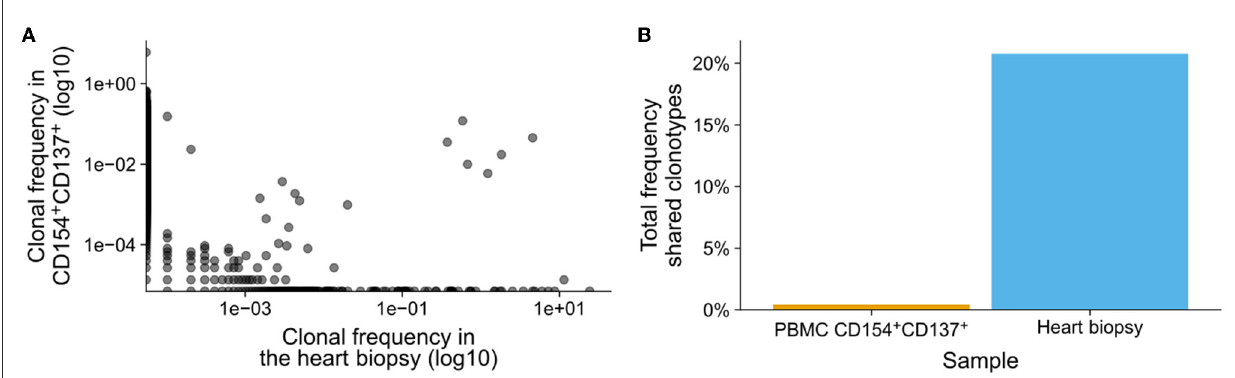
FIGURE2 SARS-CoV-2 specific T cells in heart biopsy. Peripheral blood T cells were stimulated with over lapping peptide pools from SARS-CoV-2S, M, and N proteins. Activated SARS-CoV-2-specific T cells were isolated by magnetic sorting and the T cell receptors (TCRs) were sequenced using mRNA. In parallel, TCRs from bulk mRNA from a heart biopsy were also sequenced. (A) Frequency of clonotypes identified in the heart biopsy ( n = 5,473) and in the isolated SARS-CoV-2 specific T cells after activation ( n = 130,447). The presence and frequency of clonotypes in either samples are compared in the dot-plot, the log-log-scale helps the linearize the distributions of clonotypes and thereby making them comparable. (B) Total frequency of clonotypes shared between the heart biopsy and SARS-CoV-2 specific T